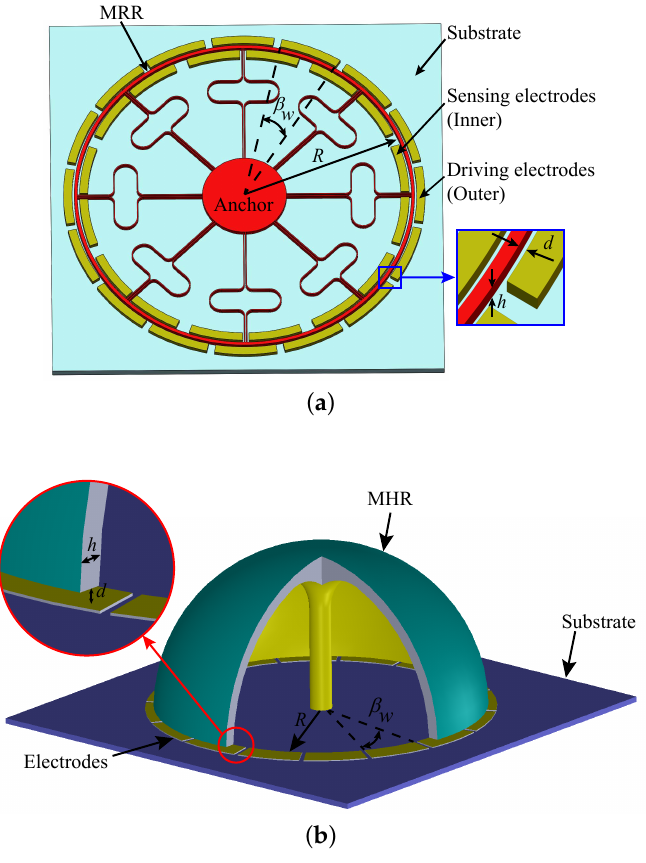
Figure 1. Circular micro-resonators in Coriolis vibratory gyroscopes (CVGs): ( a ) An micro ring resonator (MRR) with in-plane electrodes. ( b ) An micro hemispherical resonator (MHR) with in-plane electrodes.